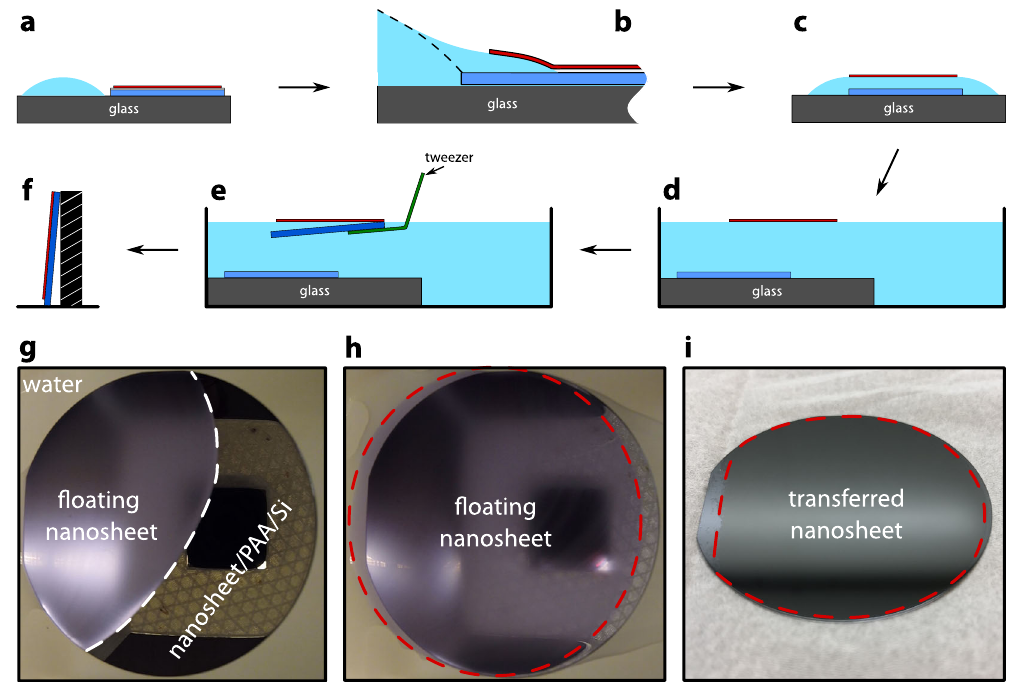
Fig. 1 Schemes and photographs of the water meniscus assisted transfer process. a A Si wafer with an OSC fi lm on a PAA interlayer is placed on a glass plate next to a water droplet, the water contact angle is ca. 50°. b After the Si wafer contacted the droplet, PAA starts to dissolve and the OSC fi lm is partially released. c After some time, the OSC fi lm is detached and fl oats on the water layer as a mechanically stable nanosheet. d The Si wafer with the fl oating nanosheet on the glass plate is immersed into a beaker fi lled with water. e The fl oating OSC nanosheet is moved to the target substrate. f The target substrate with OSC is removed from the beaker, and placed almost vertically inclined for drying. The OSC nanosheet adheres homogeneously to the substrate. g Photograph of the PAA dissolution step as illustrated in ( b ). A partially detached pentacene nanosheet (thickness of 50 nm and diameter of 3-inch) can be seen fl oating on the water meniscus. In the right side of the wafer, it can be seen that nanosheet is still attached to the wafer. The fl oating part of the nanosheet appears hazy. h The pentacene nanosheet fl oating on water after complete dissolution of PAA. The pentacene nanosheet indicated as red-dashed circle. i Photograph of the target wafer with transferred pentacene